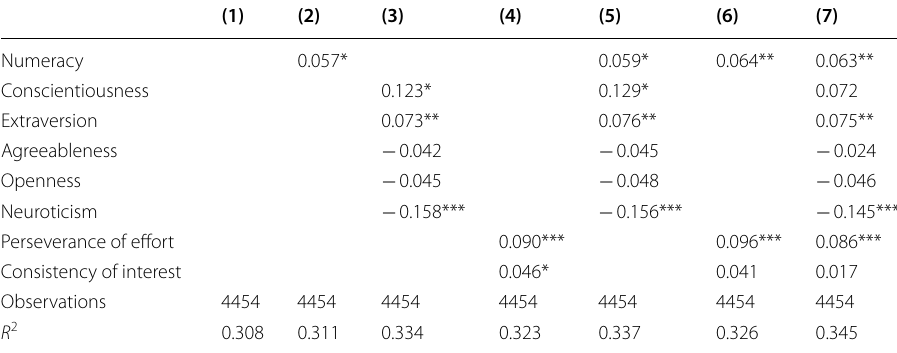
Table 6 Health and cognitive and non-cognitive